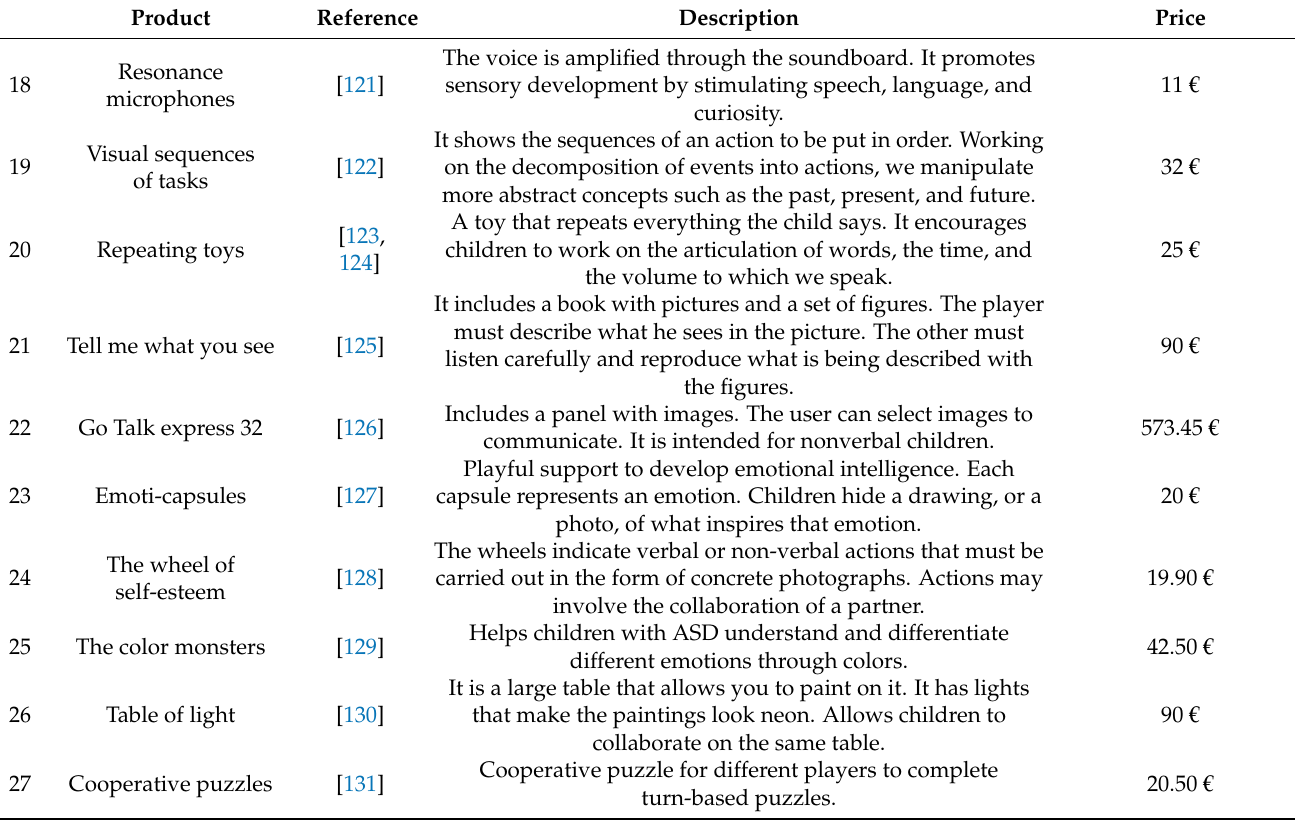
Table 17. Sample of commercial products in the form of